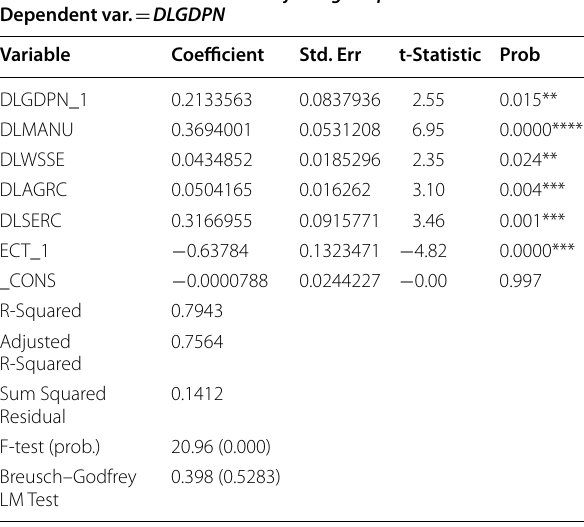
Where, *, ** and, *** indicate statistical significance levels at 10, 5 and 1 percent respectively